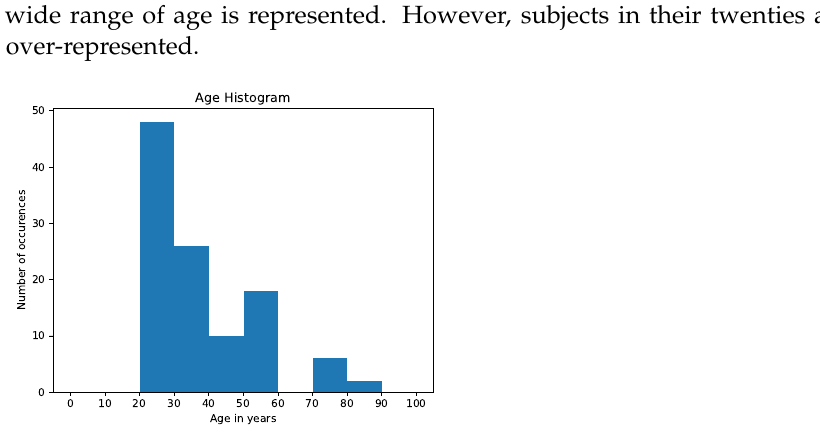
Figure 15. Clustered age histogram of study